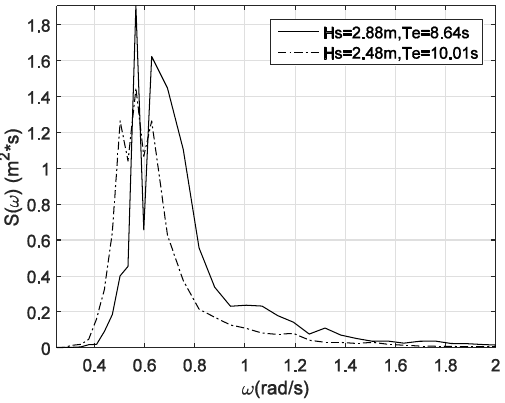
Figure 5. Spectra from the measured waves (AMETS, Belmullet, water depth = 50 m).